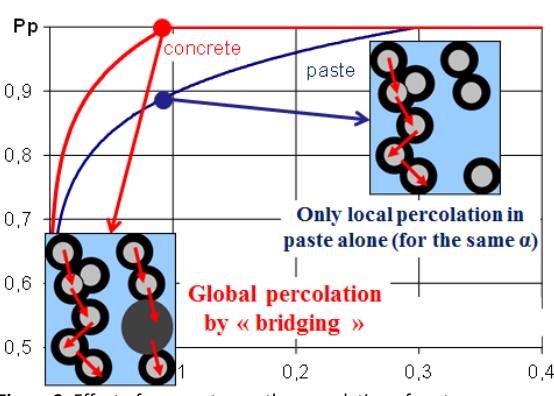
Figure 2. Effect of aggregates on the percolation of paste.